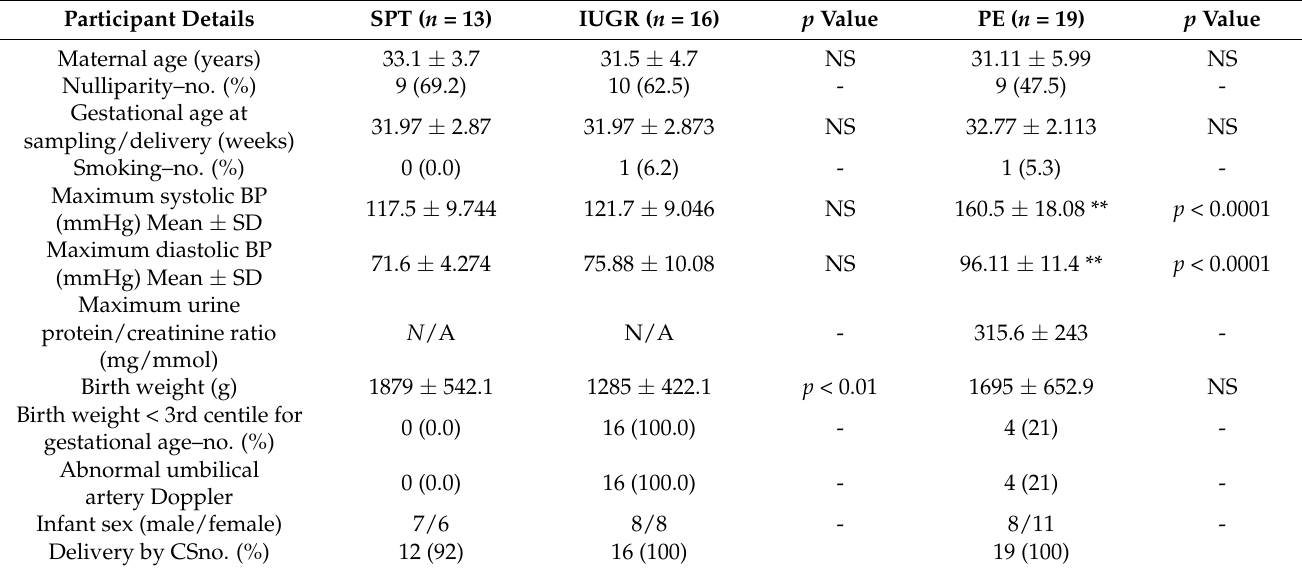
Table 1. Clinical characteristics of the study